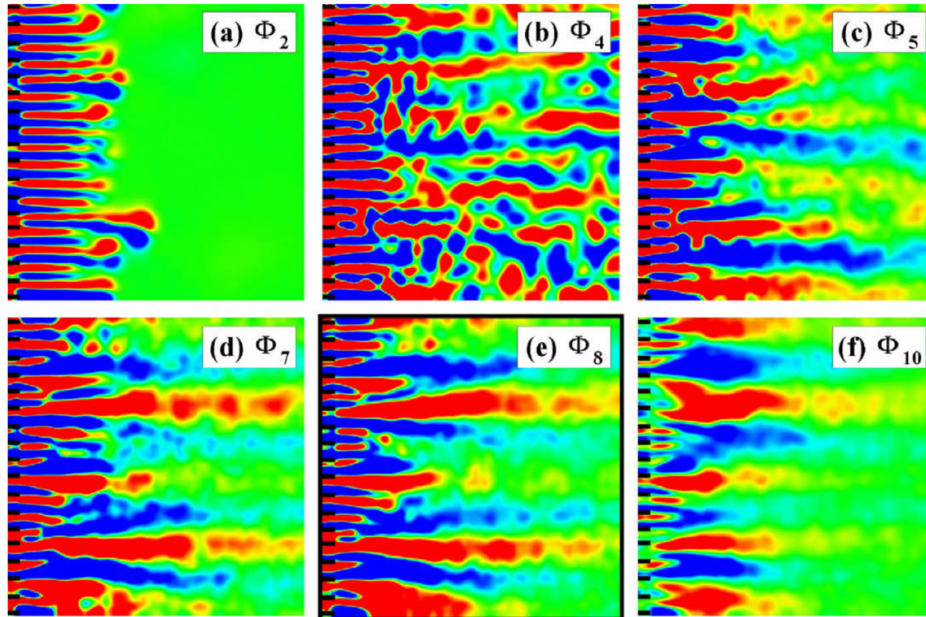
Figure 8. Typical minor loss at the ends of a parallel-plate stack [81] for six different time frames within an acoustic period ( a – f